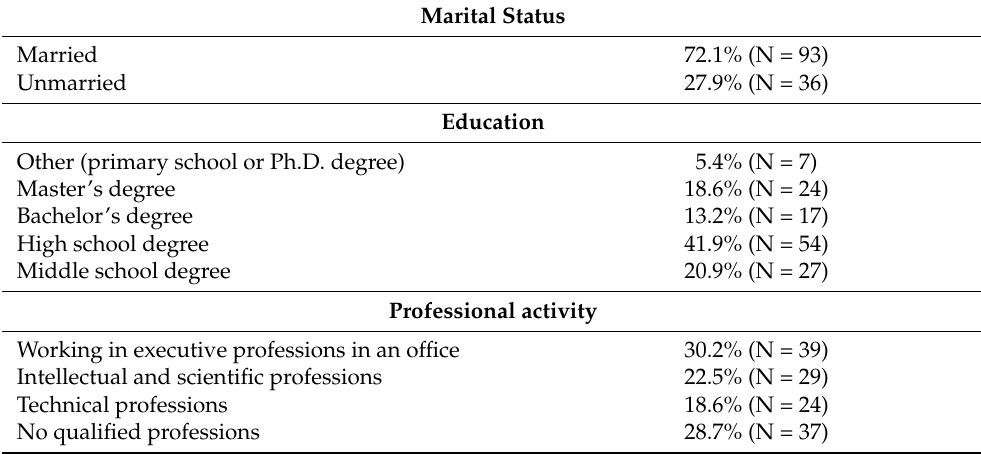
Table 1. Sociodemographic